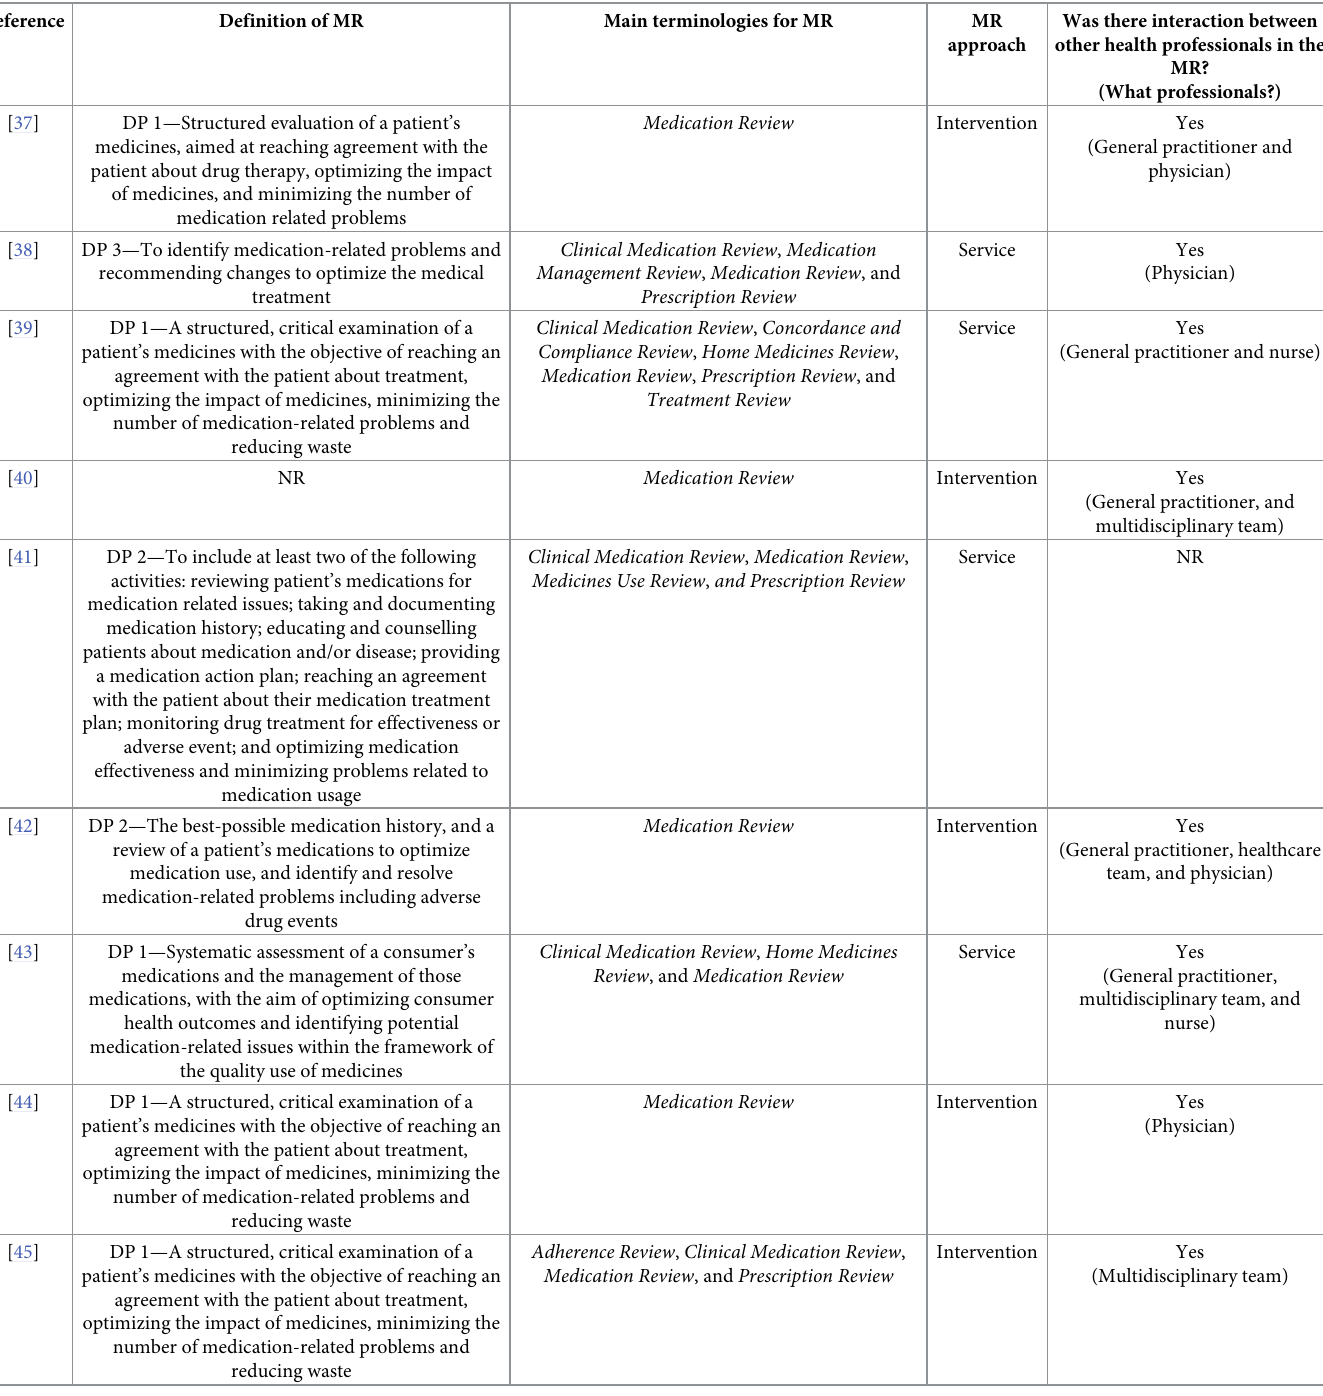
Table 3. Definition, terminology, approach of medication review (service or intervention), and interprofessional collaboration.